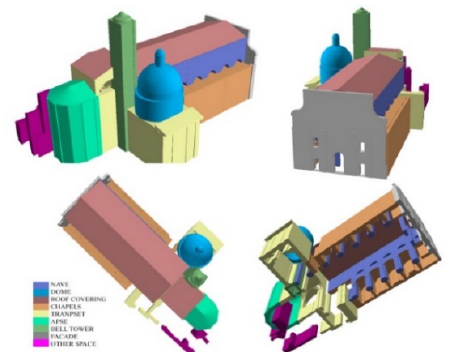
Figure 6. Building segmentation in Macro-elements according the Directive (2011).